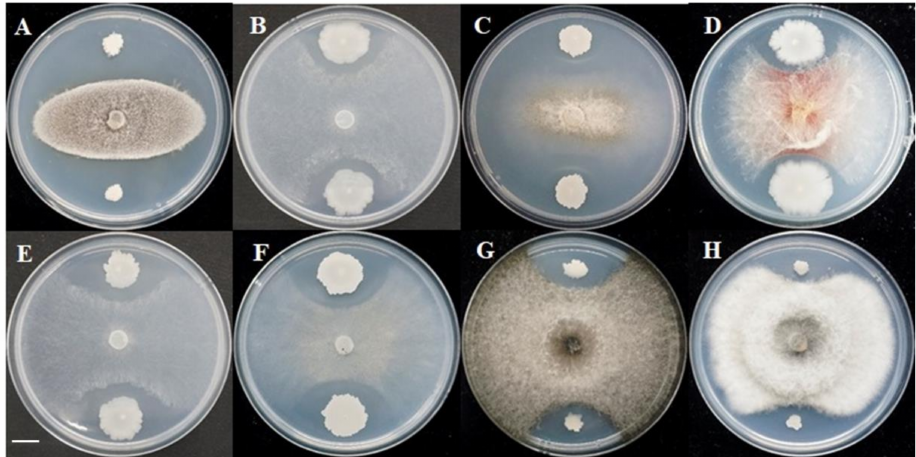
Figure 1. Antagonistic activity of B. velezensis GS-1 against plant pathogenic fungi. ( A ) Magnaporthe oryzae, ( B ) Rhizoctonia solani, ( C ) Botrytis cirerea, ( D ) Fusarium graminearum, ( E ) Sclerotinia sclerotiorum, ( F ) Cercospora zeae, ( G ) Setosphaeria turcica, ( H ) Cochiliobolus heterostrophus. Scale bar: 1